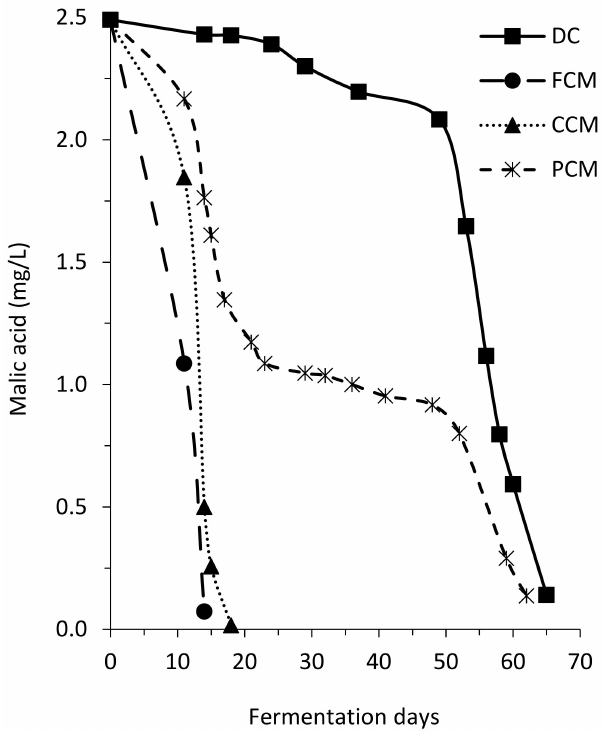
Figure 3. Evolution of malic acid consumption during vinification in the experimental winery of destemmed and crushed wines (DC) and in the different fractions obtained in the vinification by carbonic maceration (FCM: free wine, CCM: crushed wine, PCM: press wine). In the wines made by DC the MLF took place two months after the end of the